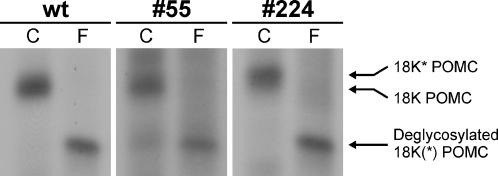
Newly synthesized 18K and 18K* POMC differ in N-glycosylation.Neurointermediate lobes (NILs) from wild-type frogs (wt) and frogs transgenic for p24α3 (#55) or p24δ2 (#224) were pulse labeled with [35S]-Met/Cys for 30 min and subsequently chased for 3 hrs. Newly synthesized proteins extracted from the NILs were deglycosylated with PNGaseF (F) or control-treated (C), resolved by 20% SDS-PAGE and visualized by autoradiography; the #55 lanes were exposed three times longer than the other lanes.